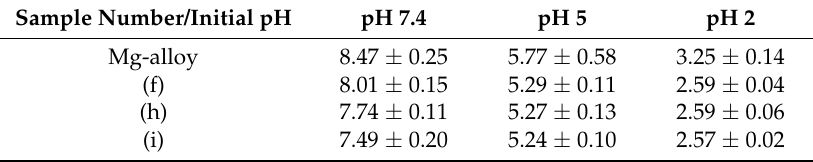
Table 3. pH measurements after 24 h for 7 days immersion in SBF solution (average